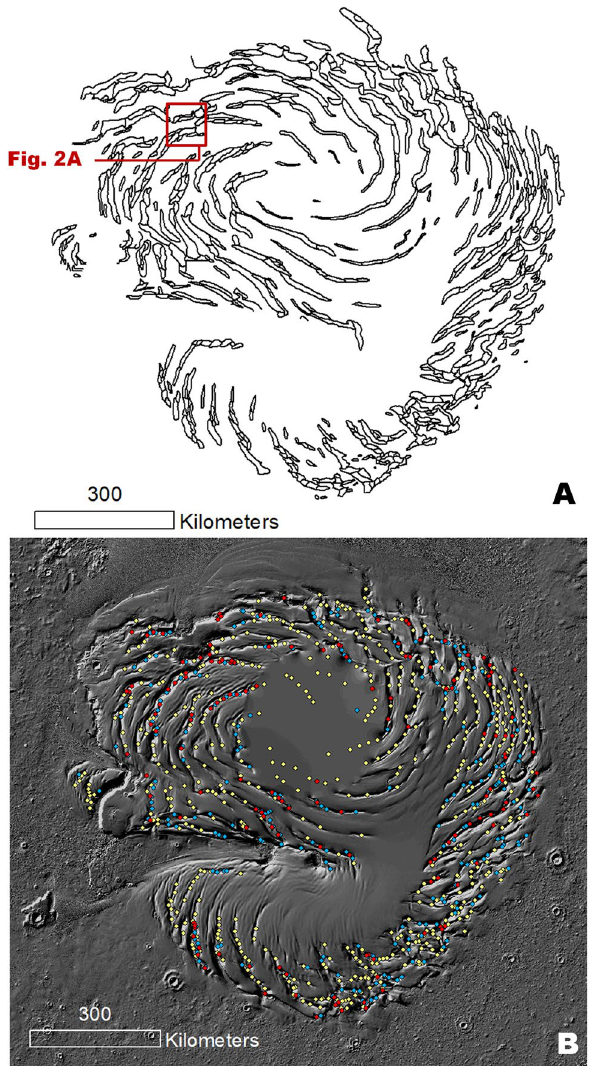
Figure 1. ( A ) Map of the NPLD troughs, including the outlines of their widespread constituent enclosed depressions (cells). The location of Fig. 2A is indicated. ( B ) Map showing a statistically significant population (950) of local image observations within the NPLD troughs, which demonstrates the presence of widespread trough interior surfaces produced by in-situ truncation. The observations include cell floor depressions (red dots) and mounds (blue dots) with concentrically layered exposures (including both equator- and pole-facing layers) and cells that only have equator-facing surface exposures (yellow dots). The base map is a MOLA shaded relief, illumination from the upper left (256 pixels/degree, credit: MOLA Science Team, MSS, JPL, NASA). We produced this figure using Esri’s ArcGIS 10.3 (http:// www. esri. com/ softw are/